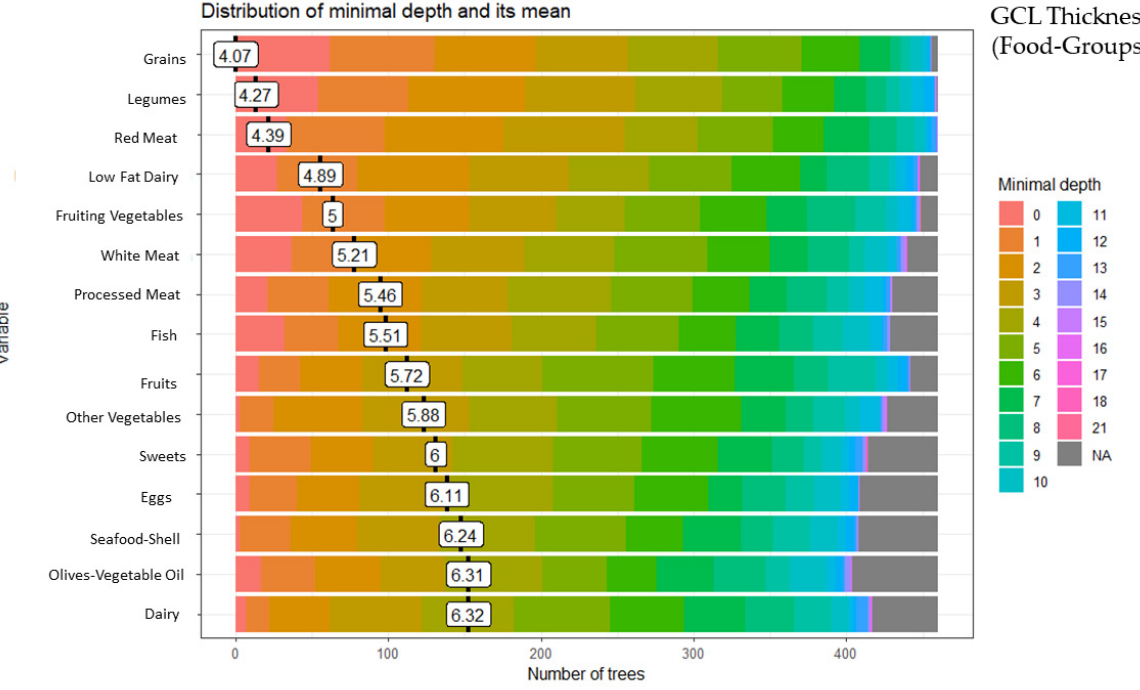
Figure 2. Random forest food group and ganglion cell layer (GCL) thickness.